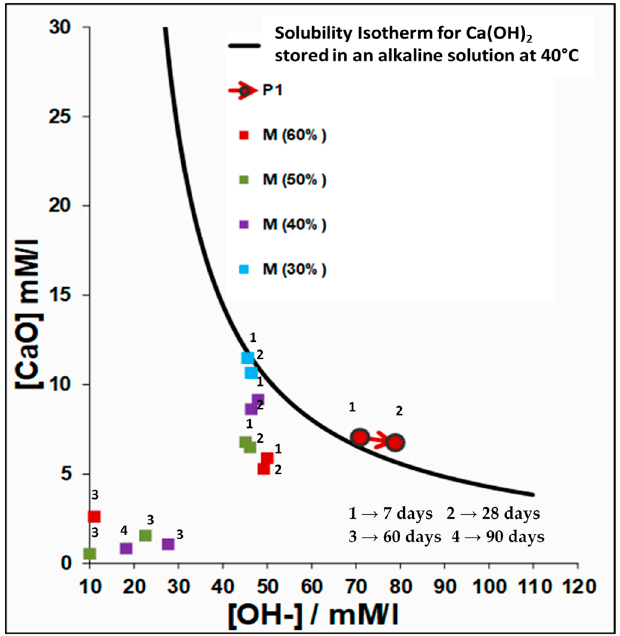
Figure 1. Frattini test results for P1 with and without calcined clay M.